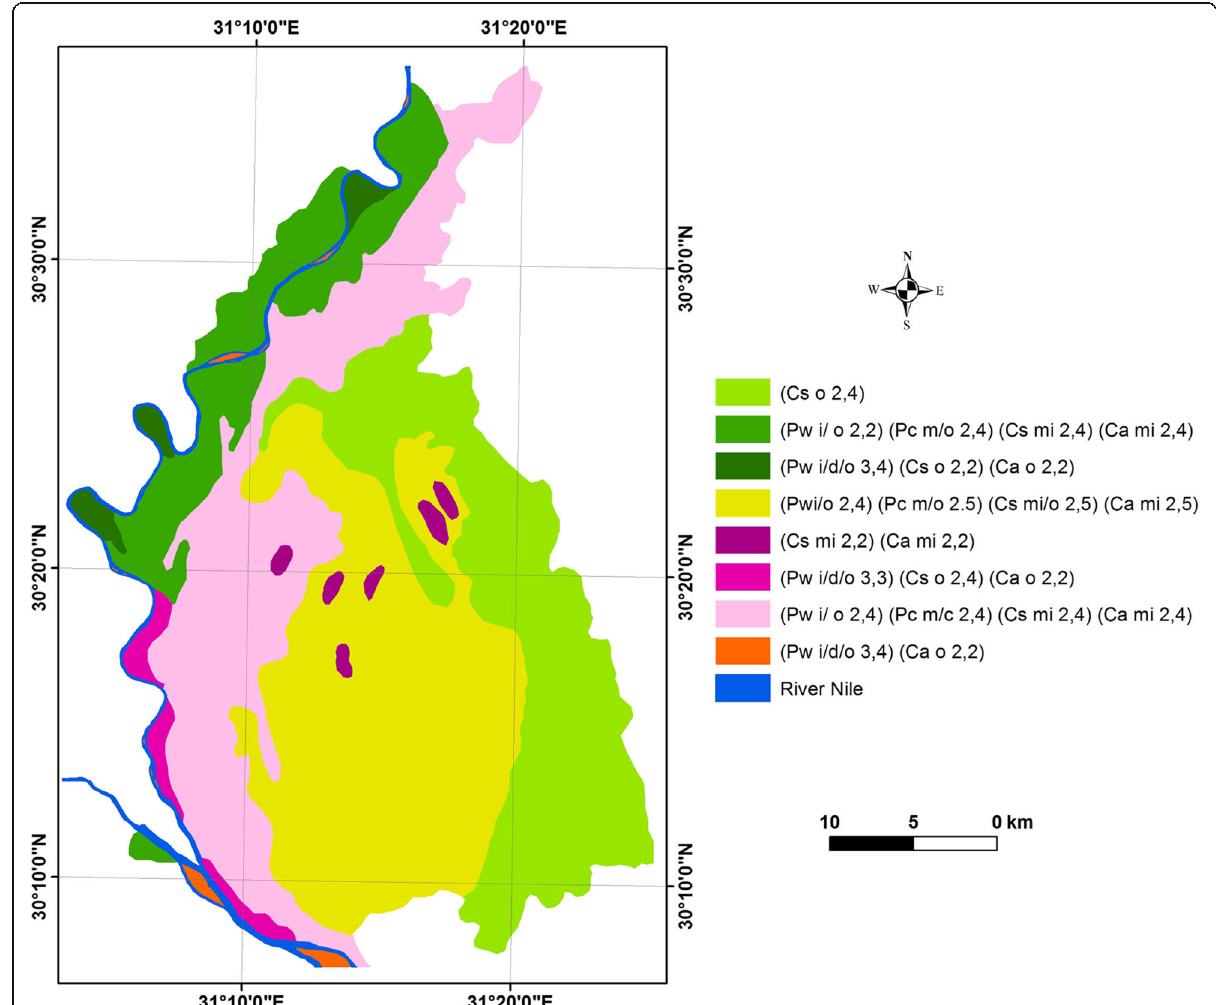
Fig. 6 Status of land degradation over Qalyubia